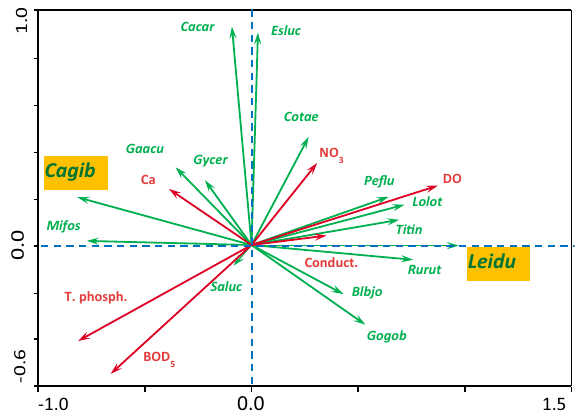
Figure 4. RDA biplot of water quality variables presented in Table 1 (after deleting collinear variables) and fish species’ biomass values obtained from samples collected in the recovered course of the Ner River, Poland, in 2000–2012. Abbreviations of water quality variables: DO dissolved oxygen, BOD 5 biological oxygen demand, NO 3 nitrates; T. Phosph. total phosphorus, Conduct. conductivity, Ca calcium. Abbreviations of fish species’ names: Blbjo — Blicca bjoerkna (silver bream); Cacar — Carassius carassius (crucian carp); Cagib — Carassius gibelio (Prussian carp); Cotae — Cobitis taenia (spined loach); Esluc — Esox lucius (pike); Gaacu — Gasterosteus aculeatus (stickleback); Gogob — Gobio gobio (gudgeon); Gycer — Gymnocephalus cernua (ruffe); Leidu — Leuciscus idus (ide); Lolot — Lota lota (burbot); Mifos — Misgurnus fossilis (weatherfish); Peflu — Perca fluviatilis (perch); Rurut — Rutilus rutilus (roach); Saluc — Sander lucioperca (pikeperch); Titin — Tinca tinca (tench).